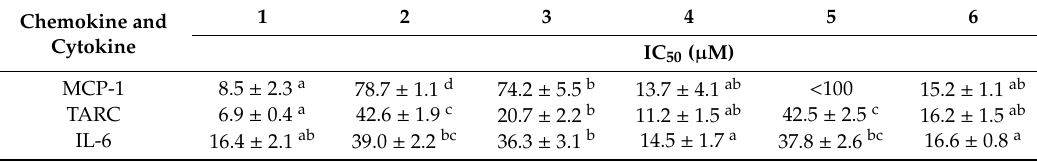
Table 2. Inhibition of chemokine and cytokine production by compounds 1 – 6